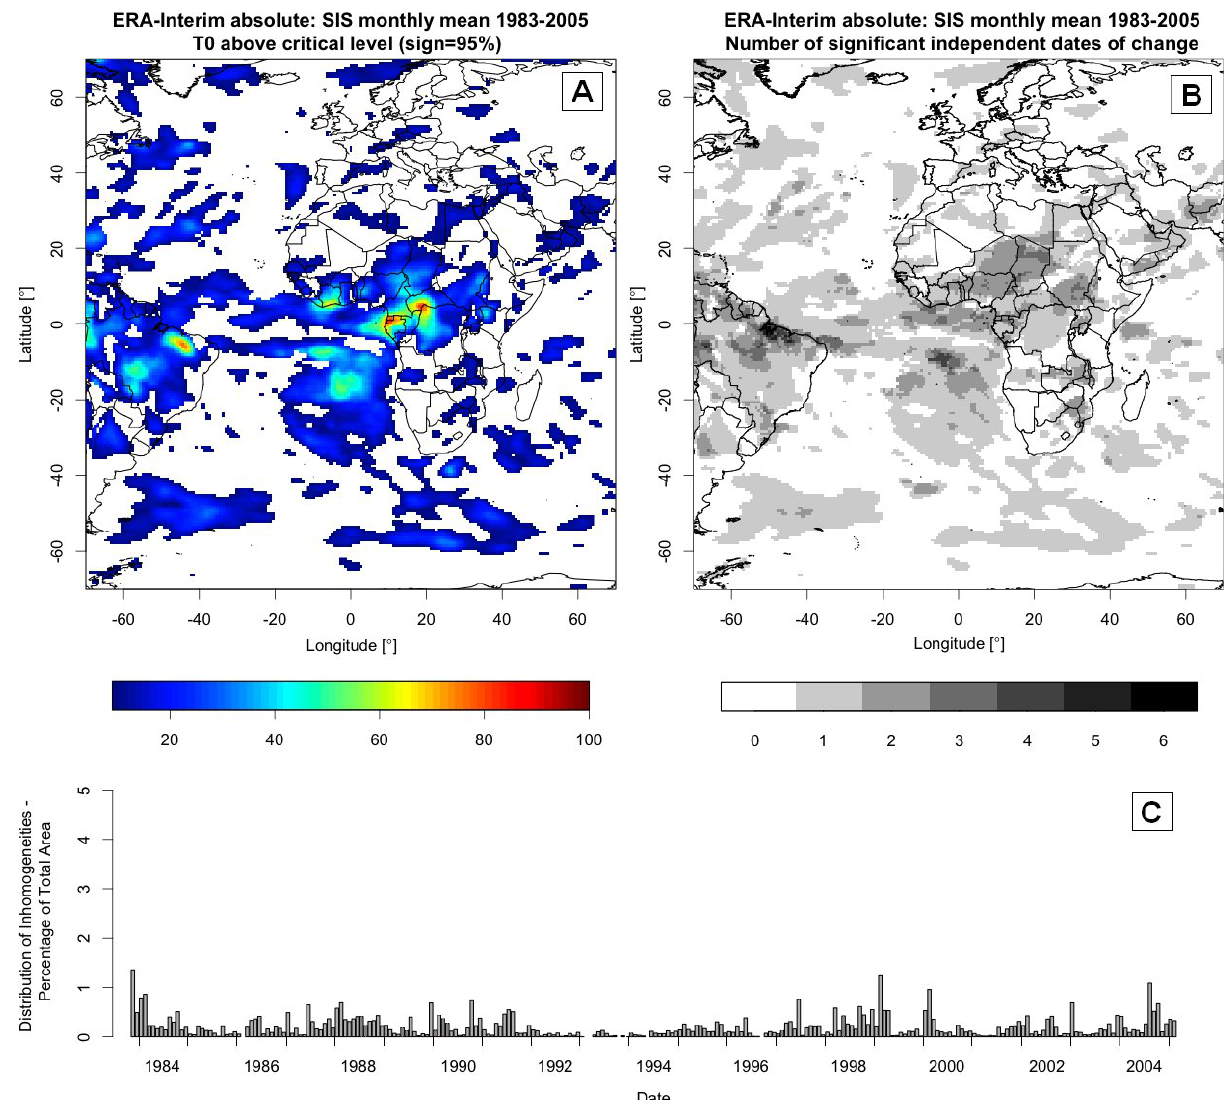
Figure 4. Absolute SNHT analysis of the ERA-Interim SIS record: ( A ) T significance level of 95%; ( B ) number of detected inhomogeneities; and ( C ) distribution of the frequency of breaks (in percent of total